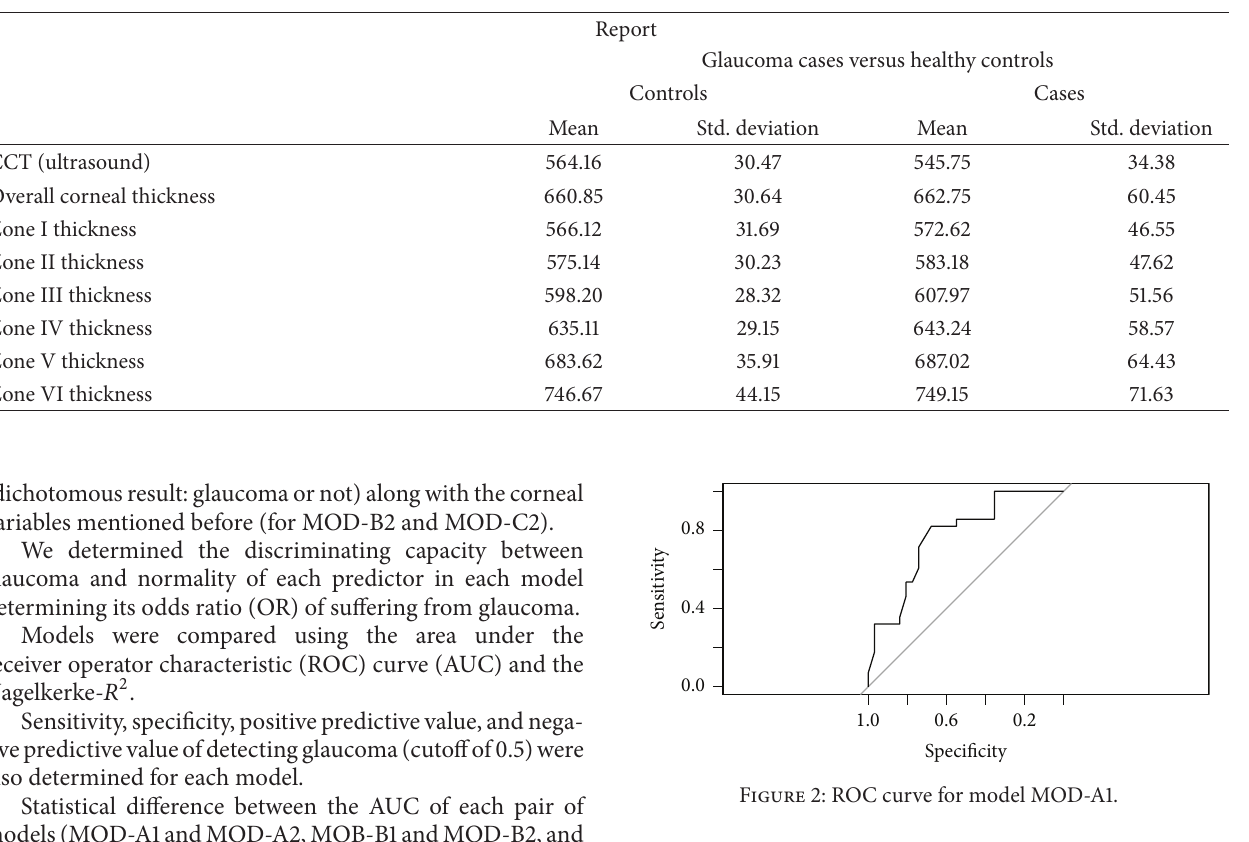
Table 1: Mean and standard deviation (std. deviation) of the corneal variables.